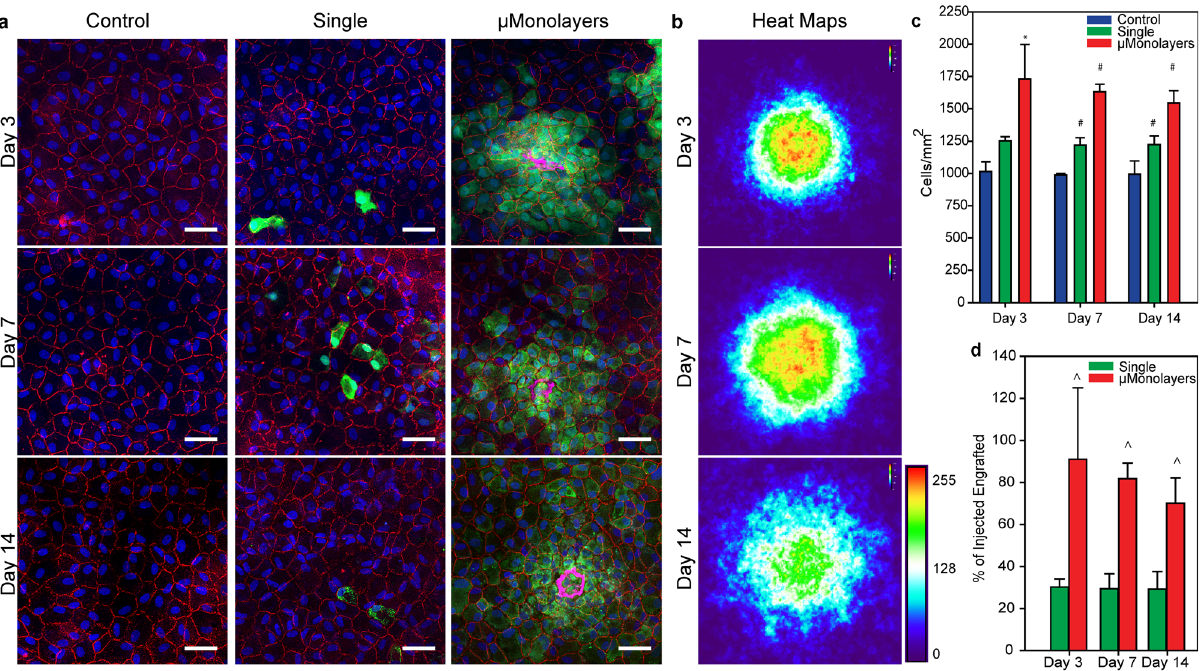
Fig. 4 Injected shrink-wrapped bovine μ Monolayers integrate into existing monolayers of bovine CE cells and signi fi cantly increase the density compared to single bovine CE cells. a Cell Tracker labeled single cells and shrink-wrapped cells were visible at all time points however, signi fi cantly more shrink-wrapped cells were present at all time points and the ECM scaffolds were still visible 14 days after injection. Scale bars = 50 μ m. b Heat maps of Cell Tracker positive pixels show that the cells in the shrink-wrapped μ Monolayers initially integrate into a tight cluster and then the density equilibrates as the cells spread out slightly (Day 3 n = 33 independent shrink-wrapped clusters, Day 7 n = 37, Day 14 n = 40, scale bar is arbitrary units). c The cell density of the monolayers was calculated and compared on days 3 ( n = 4 biologically independent samples for each sample type, each n is an average of 10 images per sample), 7 (control n = 3, single and μ Monolayer n = 4, biologically independent samples, each n is an average of 10 images per sample) and 14 (single n = 3, control and μ Monolayer n = 4, biologically independent samples, each n is an average of 10 images per sample). Data are represented as mean ± std dev and compared using one-way ANOVA on ranks with Tukey ’ s test (day 3) or one-way ANOVA with Tukey ’ s Test (day 7 and 14), where * ( p < 0.05) indicates statistically signi fi cantly different from control and # ( p < 0.05) indicates statistically signi fi cantly different from all other samples. d The percentage of the injected single and shrink-wrapped cells that were integrated into the monolayers was calculated on days 3 (n = 4 biologically independent samples for each sample type), 7 (control n = 3, single and μ Monolayer n = 4, biologically independent samples) and 14 (single n = 3, control and μ Monolayer n = 4, biologically independent samples) (each n is an average of 10 images per sample). Data are represented as mean ± std dev and compared using t test at each time point, where ^ ( p <0.05) indicates a statistically signi fi cantly different from single cells.